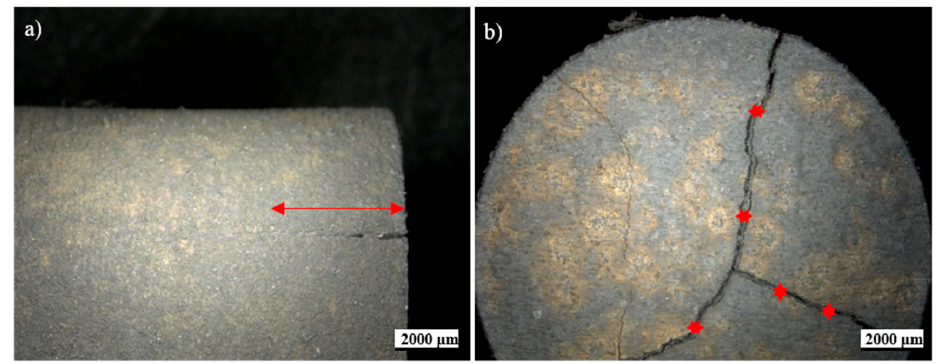
Figure 2. Experimental procedure for hot isostatic pressed (HIP’ed) cracking measurements including ( a ) cracking depth and ( b ) five crack width measurements which are used to calculate an average value.